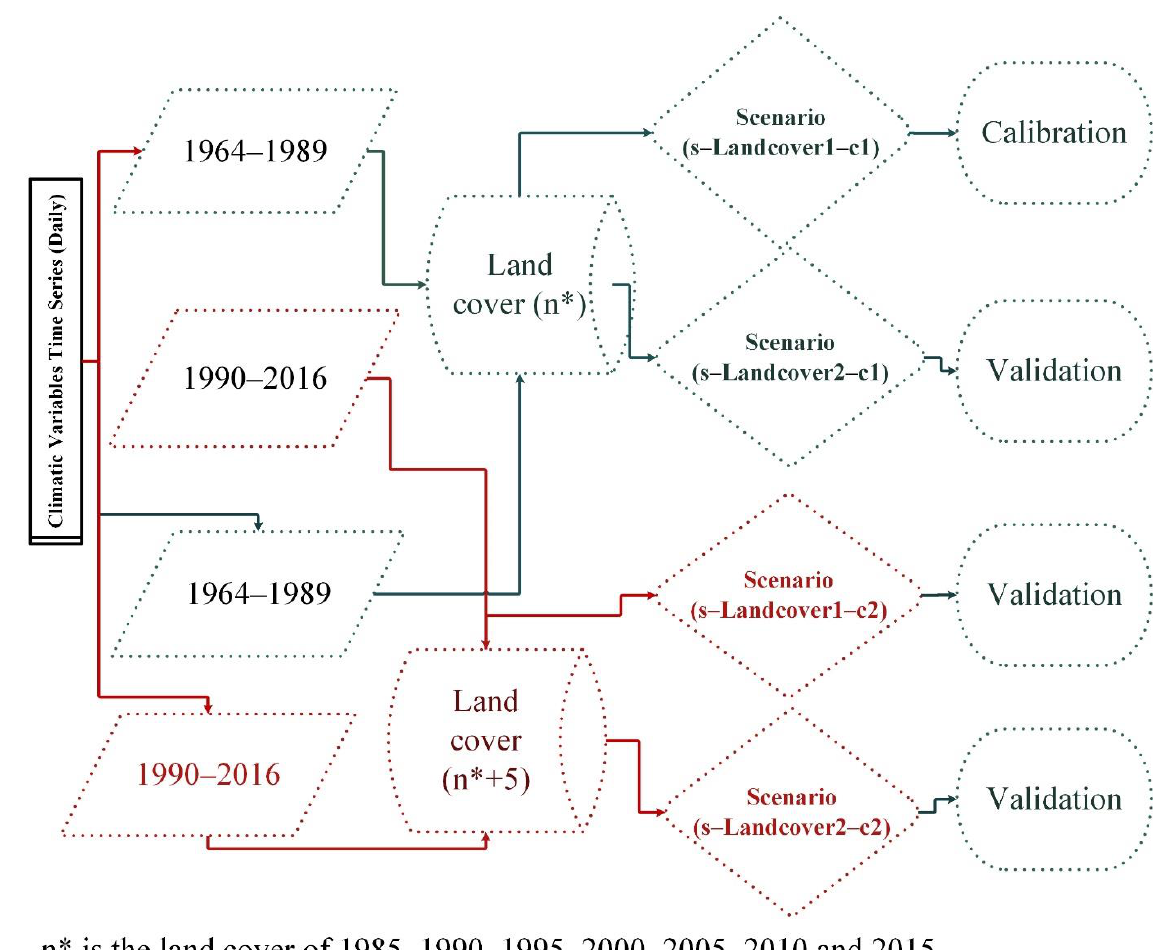
Figure 4. Flowchart for estimation of attribution of changes in streamflow to climate change and land-cover change.